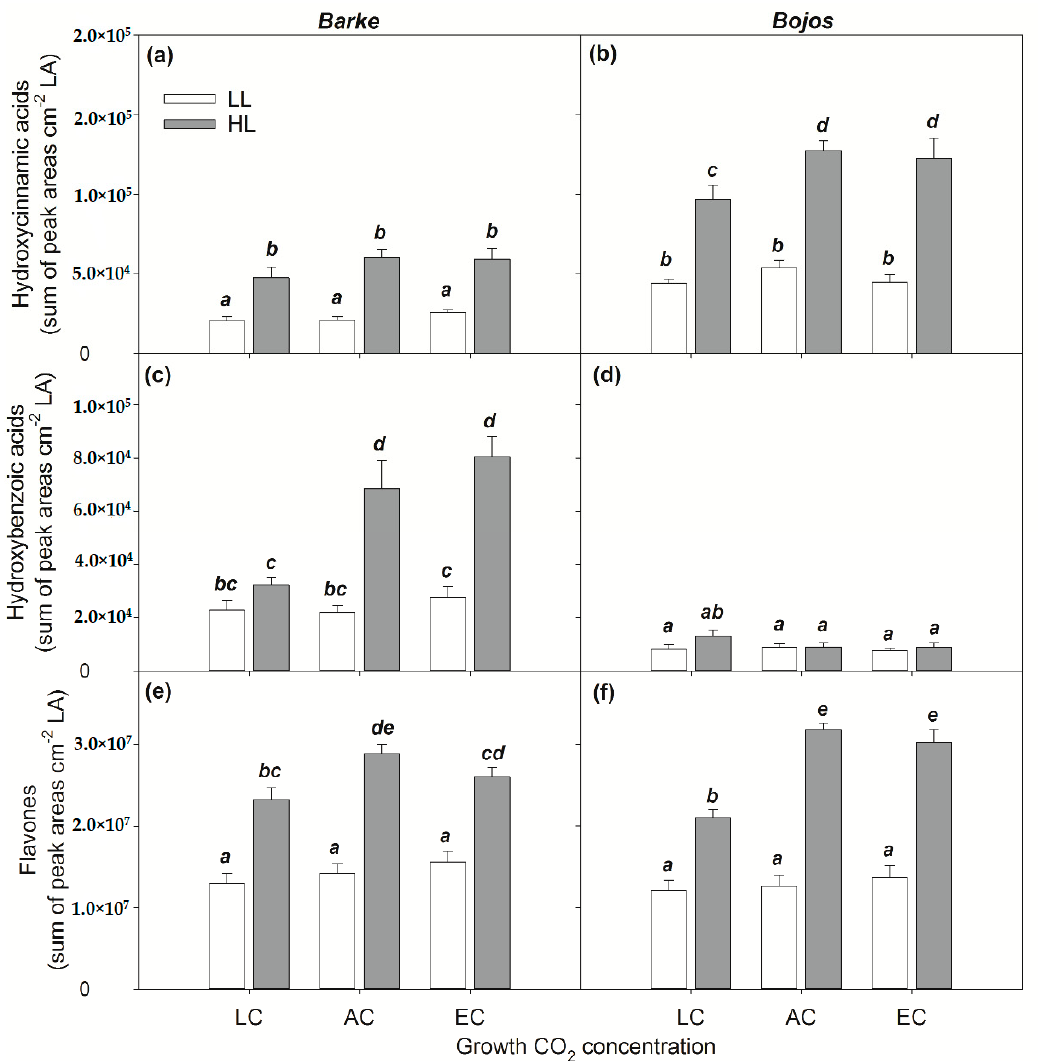
Figure 6. The effect of barley ( Hordeum vulgare) variety on the accumulation of different groups of PhCs per unit leaf area (LA) under experimental treatment measured by HPLC-HRMS. ( a , c , e ) relatively tolerant Bojos ( b , d , f ) oxidative-stress sensitive Barke; Light intensity: white columns-low light (LL); grey columns–high light (HL); and CO 2 concentration: low (LC), ambient (AC) and elevated (EC) on total amount of ( a , b ) hydroxycinnamic acids, ( c , d ) hydroxybenzoic acids, and ( e , f ) flavones. The means (columns) and standard errors (error bars) are presented (n = 6). Different letters above columns indicate statistically significant differences between means tested by Fisher’s LSD post hoc test ( p = 0.05) across both vari- eties.